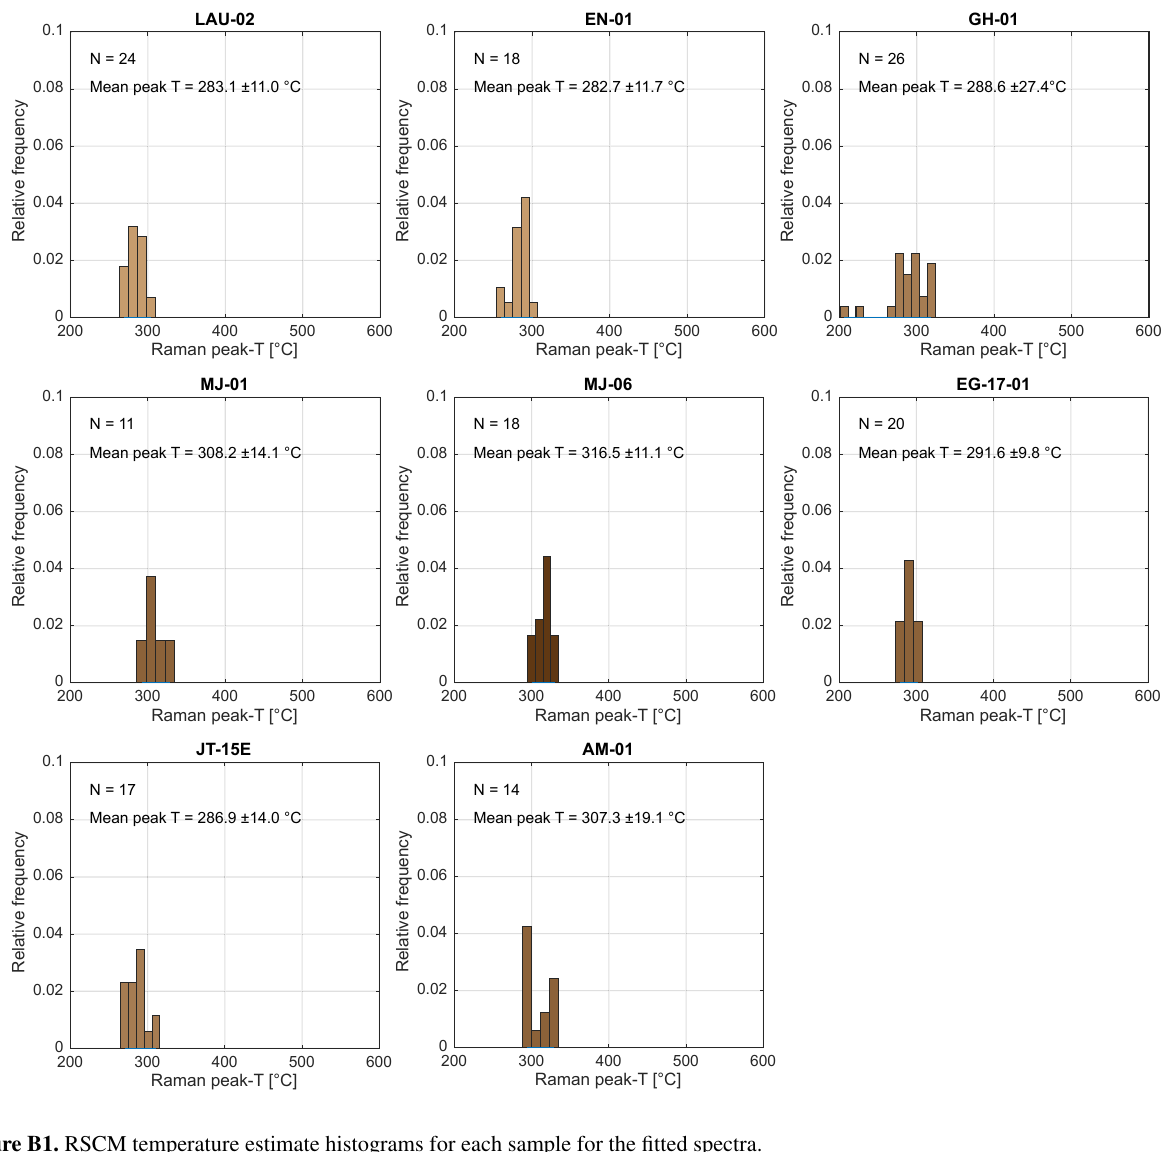
Figure B1. RSCM temperature estimate histograms for each sample for the fitted